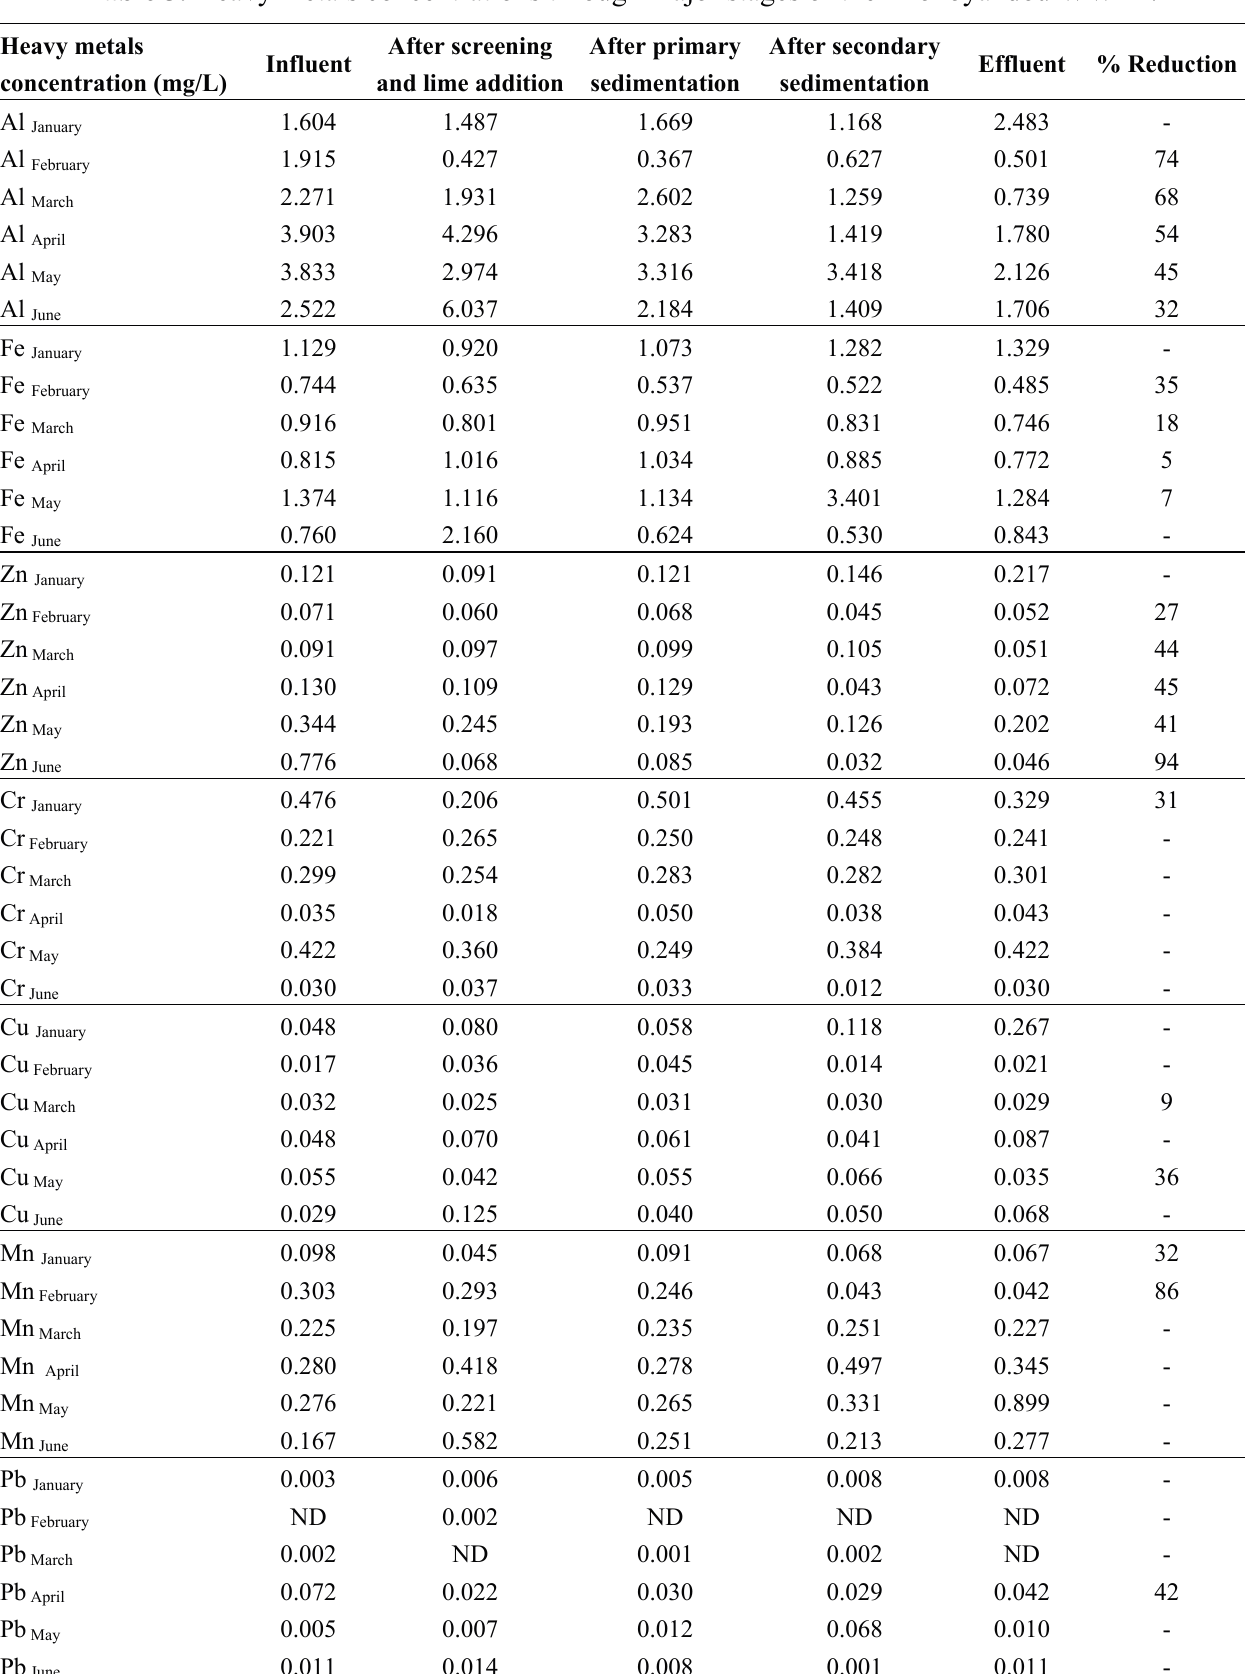
Table 3. Heavy metals concentrations through major stages of the Thohoyandou